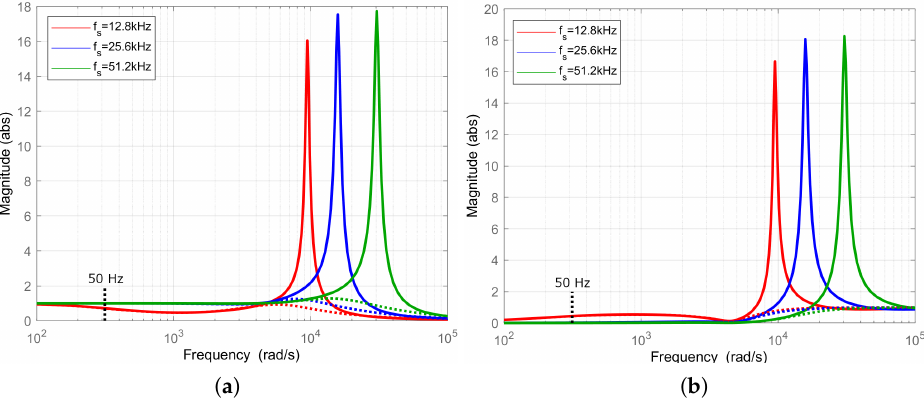
Figure 15. ( a ) Complementary sensitivity T ( ω ) and ( b ) sensitivity S ( ω ) of the closed-loop no-load systems; f s = 12.8 kHz: f r = 1508 Hz; f s = 25.6 kHz: f r = 2514 Hz; f s = 51.2 kHz: f r = 4842